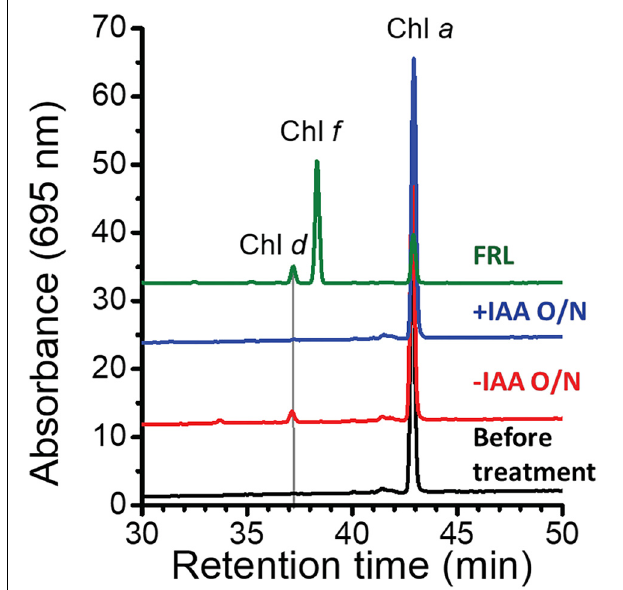
FIGURE 4 | Effects of thiol compounds on Chl d production in pigment extracts from C. fritschii 9212. The figure shows the RP-HPLC elution profiles of pigments at 695 nm, the absorption maximum of Chl d . Pigments were extracted from C. fritschii 9212 cells grown in WL or FRL (green line, control). RP-HPLC analysis was then performed before treatment (black line), after incubation at room temperature overnight in the dark without IAA (–IAA O/N; red line) or after IAA treatment (+IAA O/N; blue line). The retention times of Chl d , Chl f , and Chl a are indicated. Pigments extracted from cells grown in FRL show the retention times for Chl d , Chl f , and Chl a , respectively. IAA, iodoacetamide; O/N,